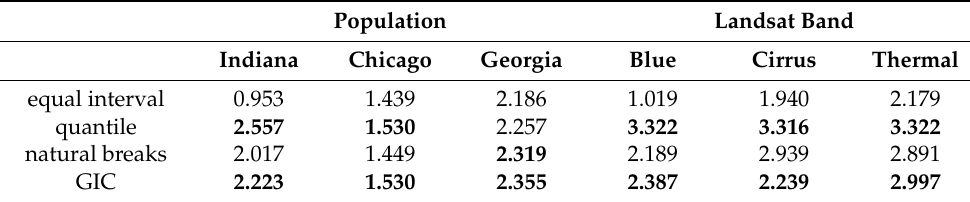
Table 6. Information entropy of the classification results from GIC and comparison